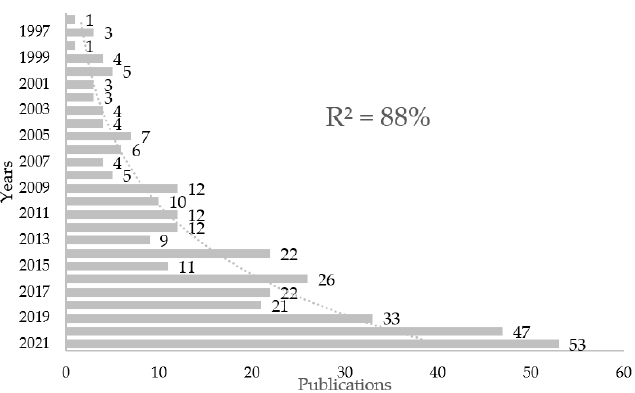
Figure 1. The exponential growth of annual publications on Suicide and Physical Activity.